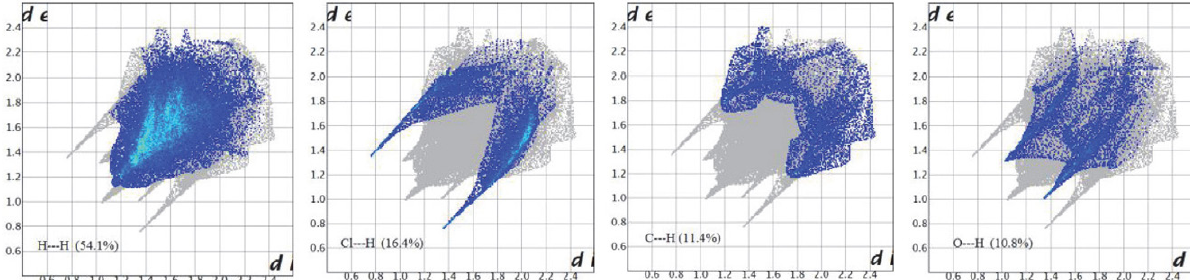
Fig. 4. The 2D fingerprint plots and relative contributions to the percentage of Hirshfeld surface for various interactions in complex 1